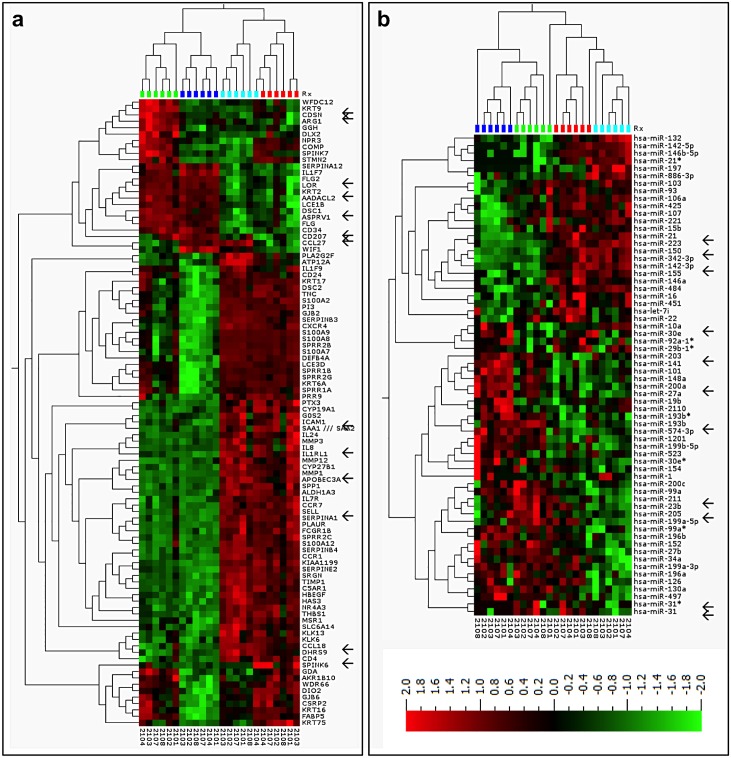
Topical treatment with ingenol mebutate 0.05% gel affects expression of gene clusters relevant for inflammatory and wound healing responses, and induces a characteristic microRNA (miRNA) pattern.The profiles illustrated are heat-maps and 2-way hierarchical clusterings of deregulated genes of (A) the 95 most variable mRNAs, and (B) the 64 most variable miRNAs across samples (n = 24) for the first six patients in the study. Differentially expressed genes and miRNAs were identified by pair-wise comparison of the following groups: actinic keratosis day 0 (AK0) versus uninvolved skin day 0 (US0), AK2 versus AK0, US2 versus US0, and AK2 versus US2. The expression analysis included variance filtering (VAR >0.2), statistical significance test by analysis of variance (P < 0.01), expression cut-off (>2-fold), and the false-discovery-rate was controlled by the Benjamini-Hochberg procedure (q < 0.05). Microarray data can be found in the GEO repository (GSE63107). Arrows indicate mRNA genes and miRNAs that were selected for validation by quantitative polymerase chain reaction. The colors above the heat map indicate: US0 (dark blue, n = 6), US2 (light blue, n = 6), AK0 (green, n = 6), and AK2 (red, n = 6) samples, respectively. The red and green shades on the heatmap represent up- and down-regulated genes, respectively.